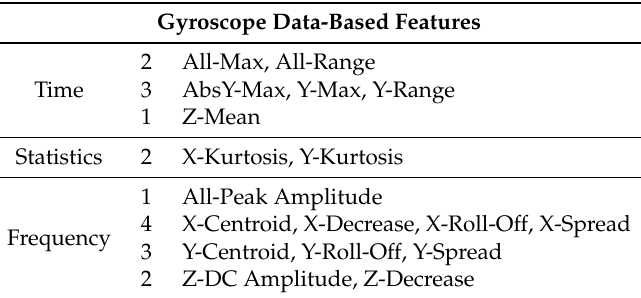
Table 5. Features extracted on gyroscope